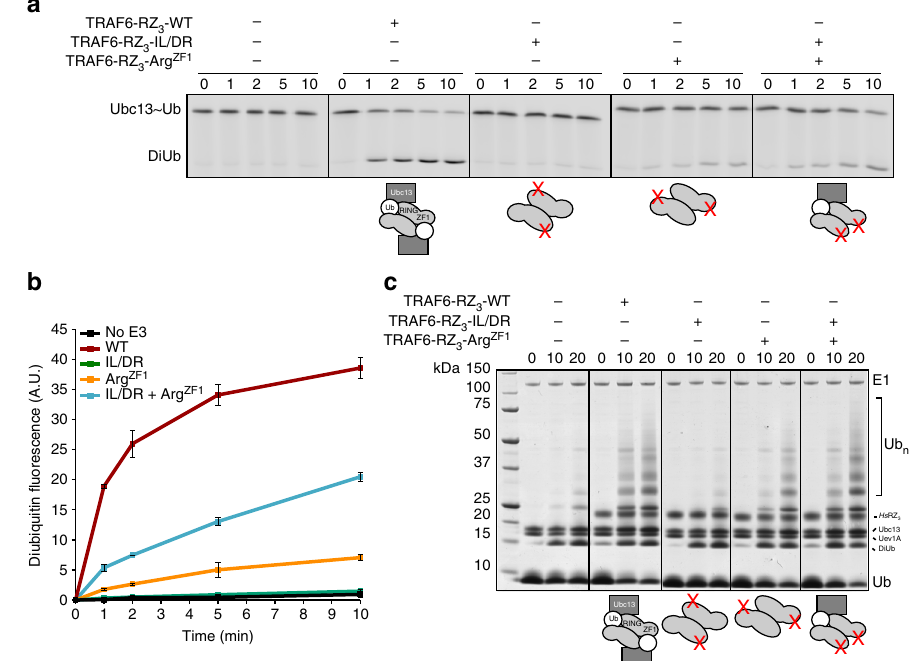
Fig. 3 TRAF6 dimers with a single conjugate binding site are active. a Single-turnover assay using fl uorescently labelled conjugate performed as in Fig. 2c. Mutant proteins that disrupted either the E2 interface (IL/DR) or ubiquitin binding (Arg ZF1 ) were incubated with the conjugate alone, or following mixing (far right). Schematics indicate the site of each mutation on TRAF6. b The formation of diubiquitin from panel a was quanti fi ed. Experiments were performed in duplicate; error bars represent range of measurements. c Coomassie blue stained chain-building assay using TRAF6 RZ 3 mutants from panel